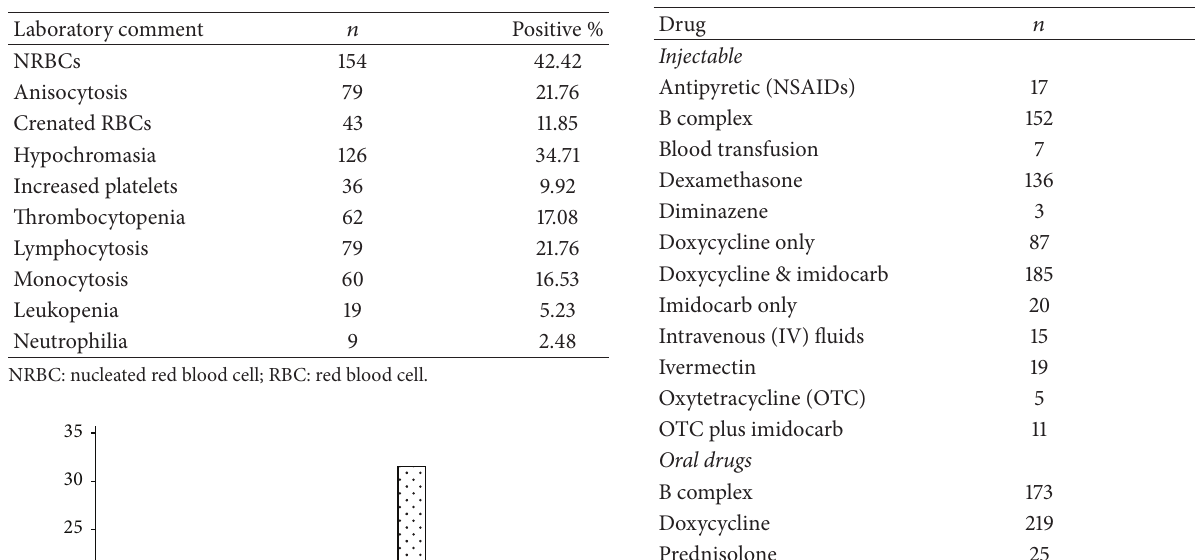
Table 3: Other haematological findings from blood samples from Babesia -positive dogs ( 𝑛 = 363 ) in Zambia.